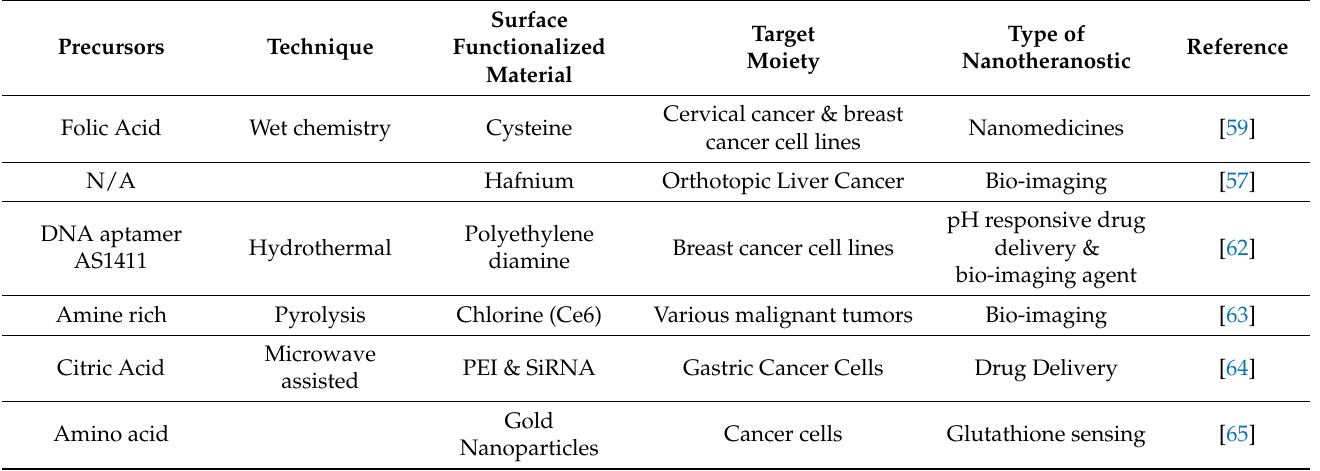
Table 1. Precursors, technique, surface functionalization, target moiety, and applications of CDs as